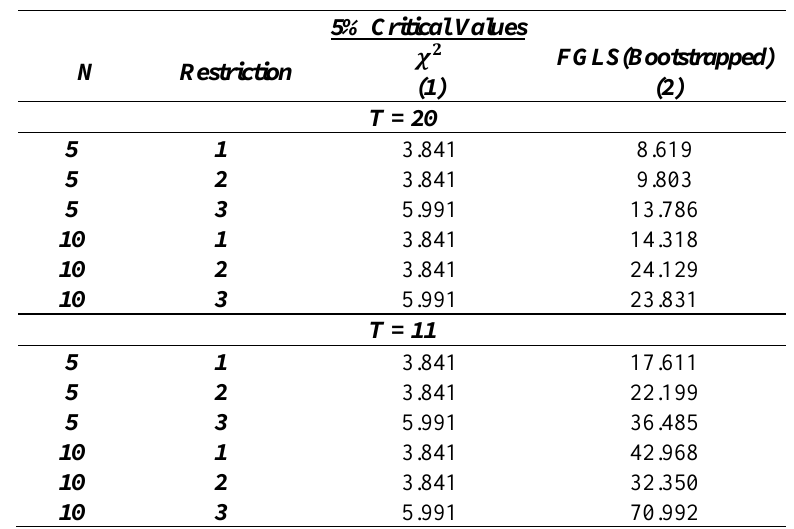
Table 1 : Comparison of bootstrapped